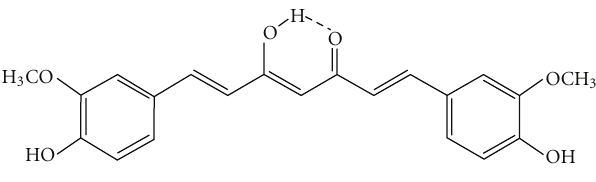
Figure 1: Chemical structure of